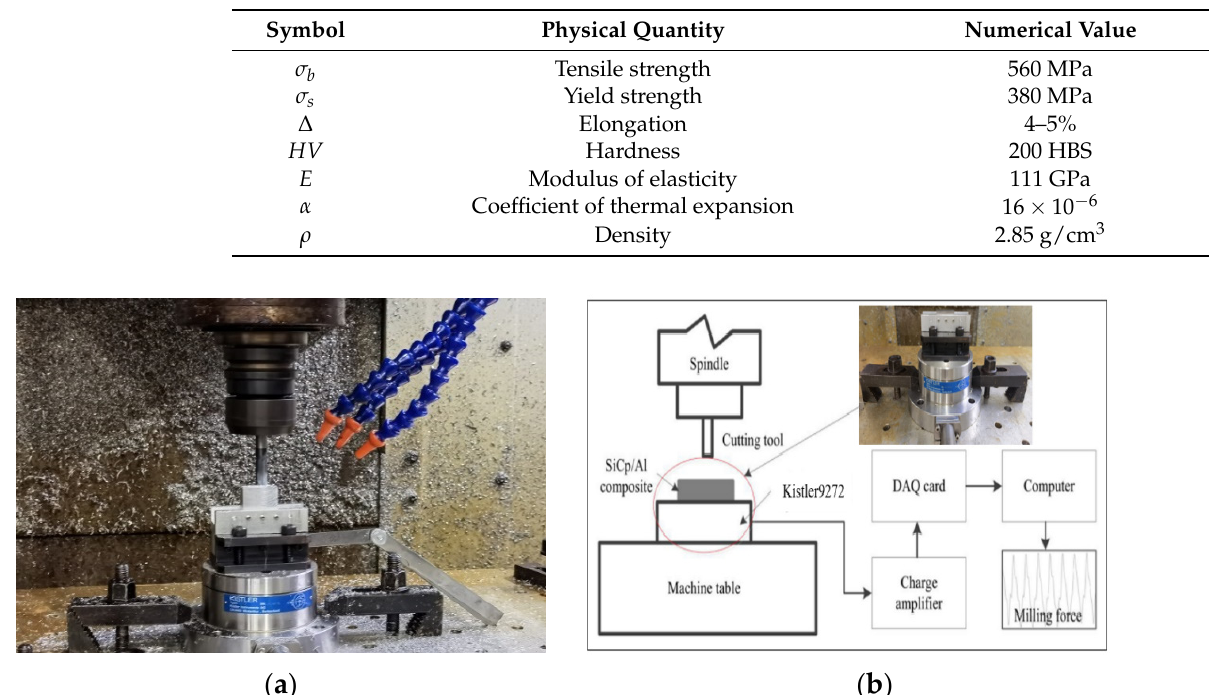
Table 1. Table of physical property parameters of SiCp/Al.